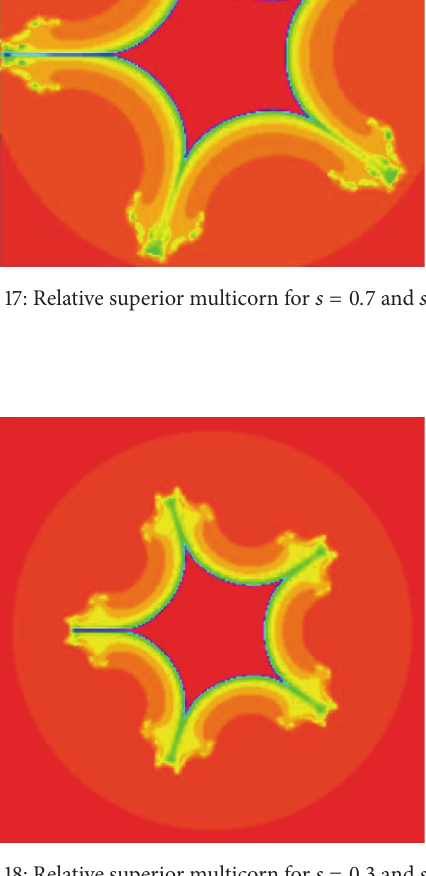
Figure 18: Relative superior multicorn for 𝑠 = 0.3 and 𝑠 󸀠 = 0.8 .